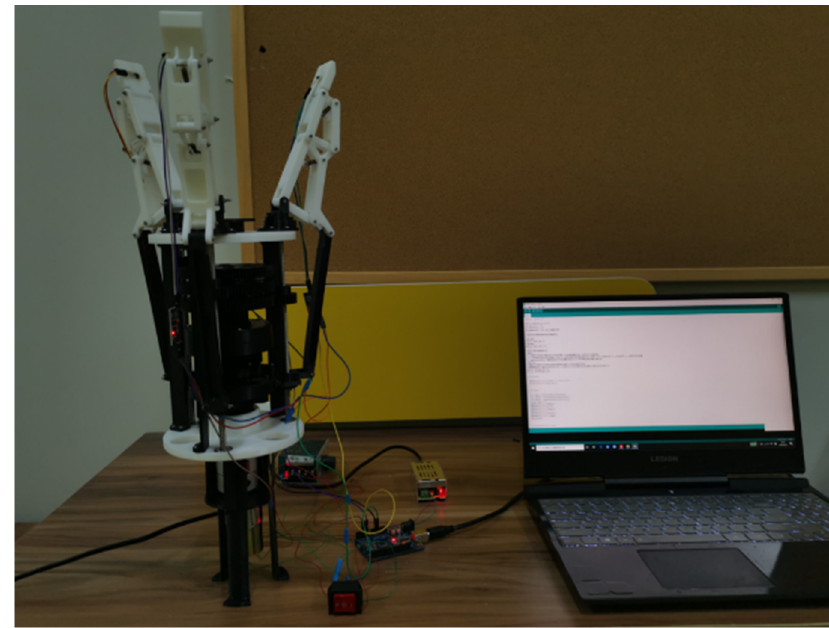
Figure 15. Underactuated manipulator.